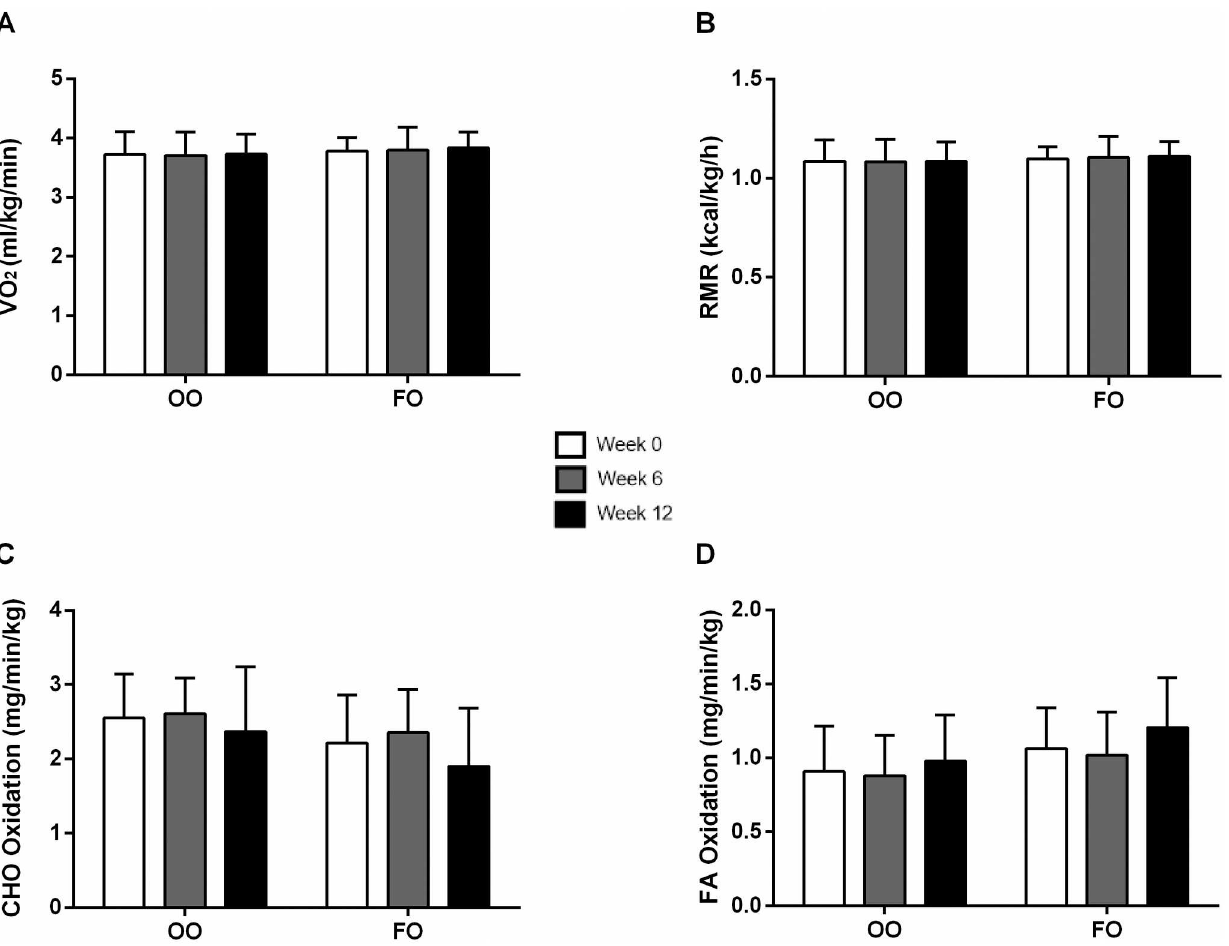
Fig 3. Resting oxygen consumption (VO 2 ) (A), resting metabolic rate (RMR) (B), carbohydrate (CHO) oxidation (C), and fatty acid (FA) oxidation (D) normalized to body massat weeks 0, 6 and 12 of olive oil (OO) and fish oil (FO) supplementation. Valuesare reportedas means ± SD. There were no differences betweenthe